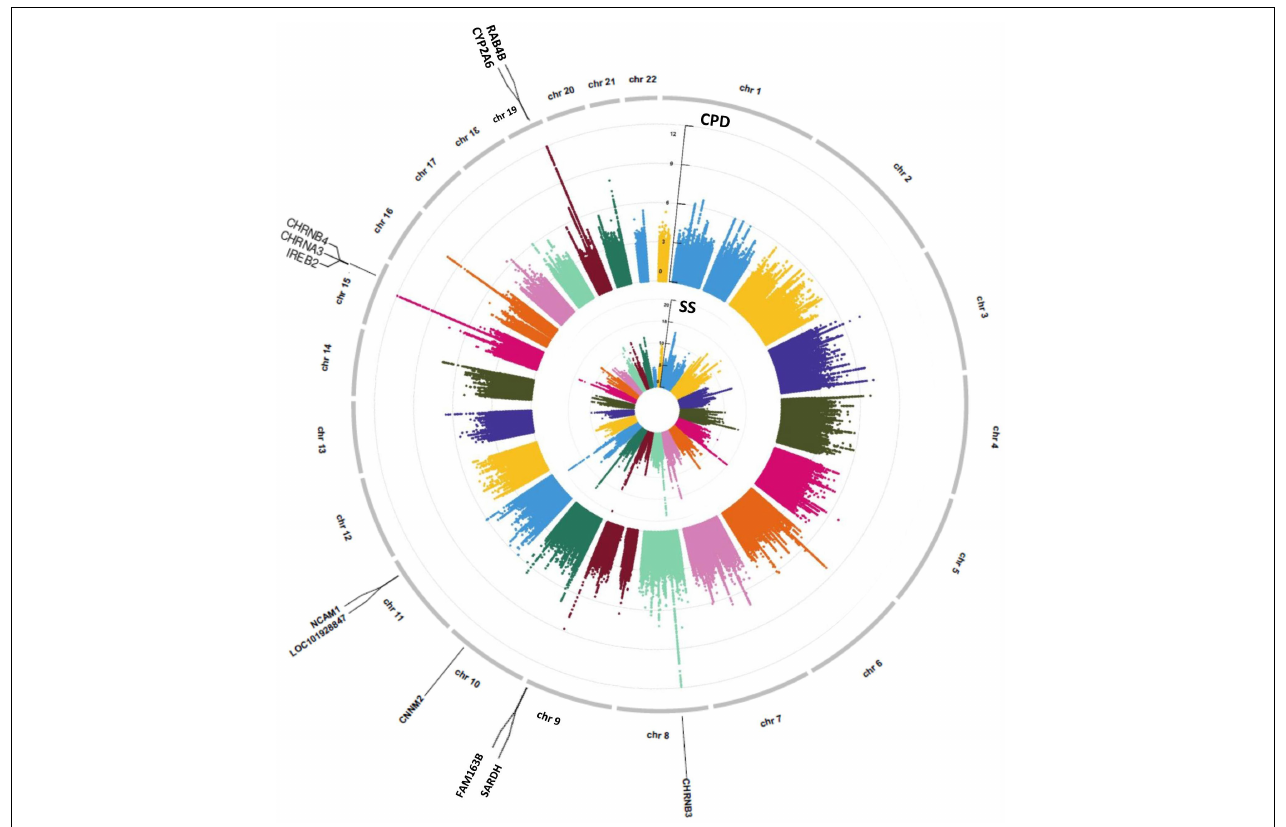
FIGURE 2 | A concentric circular Manhattan plot of the GWAS results for smoking status (SS) and cigarette per day (CPD) for chromosomes 1–22. Each dot represents an SNV; x - and y -axis refer to genomic locations and –log10( p -value). The SNVs with –log10( p -value) are larger than 12 for chr15 and chr19 of CPD, and larger than 20 for chr9 and chr11 of SS were not included in the plot. The three highest signals mapped on genes CHRNB3 , CHRNA3 , CHRNB4 , IREB2 , CYP2A6 , and RAB4B of CPD and the four highest signals mapped on genes FAM163B , SARDH , CNNM2 , and NCAM1 and lncRNA LOC101928847 of SS are labeled in the plot. GWAS, genome-wide association study; CPD, cigarette per day; SNV, single-nucleotide variant.